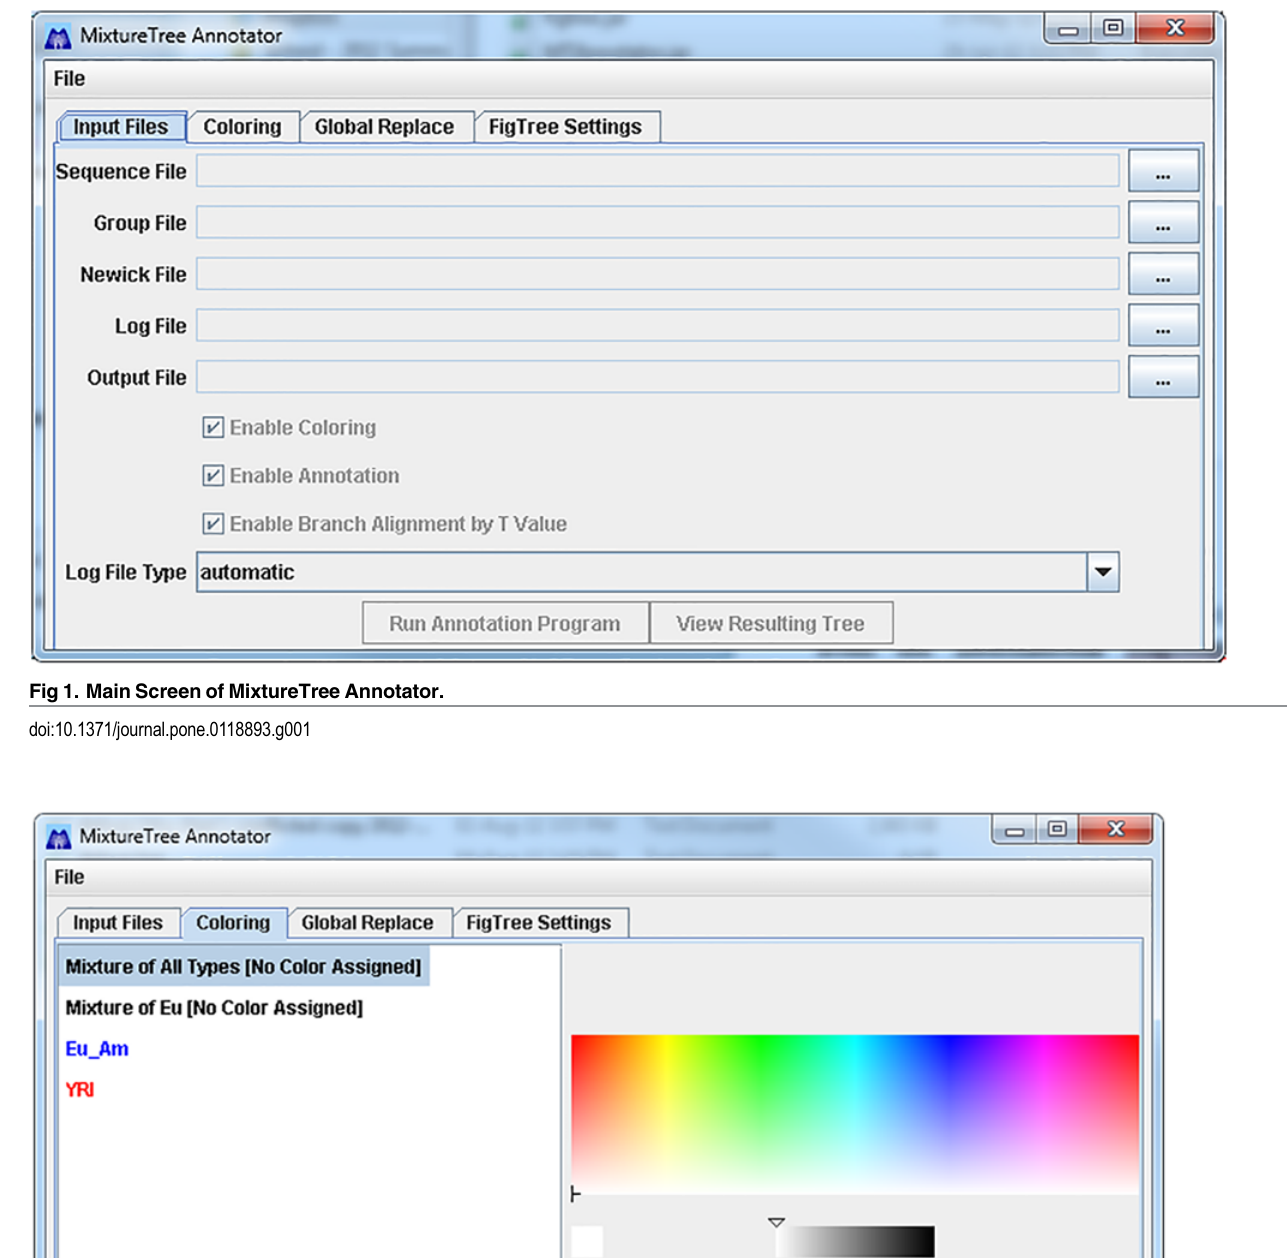
PLOS ONE | DOI:10.1371/journal.pone.0118893 March 31,